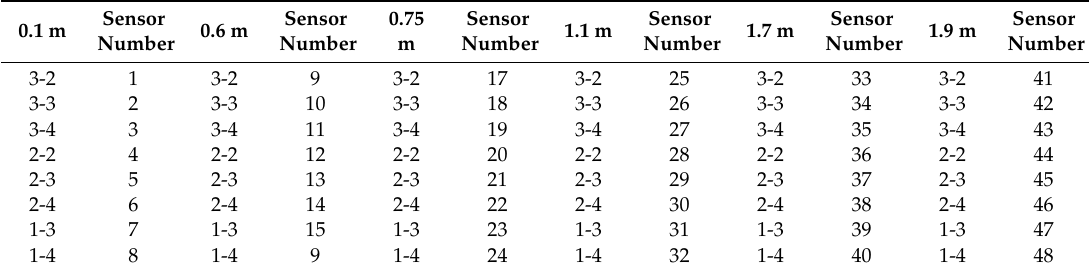
Table 11. Correspondence table between each sensor and actual